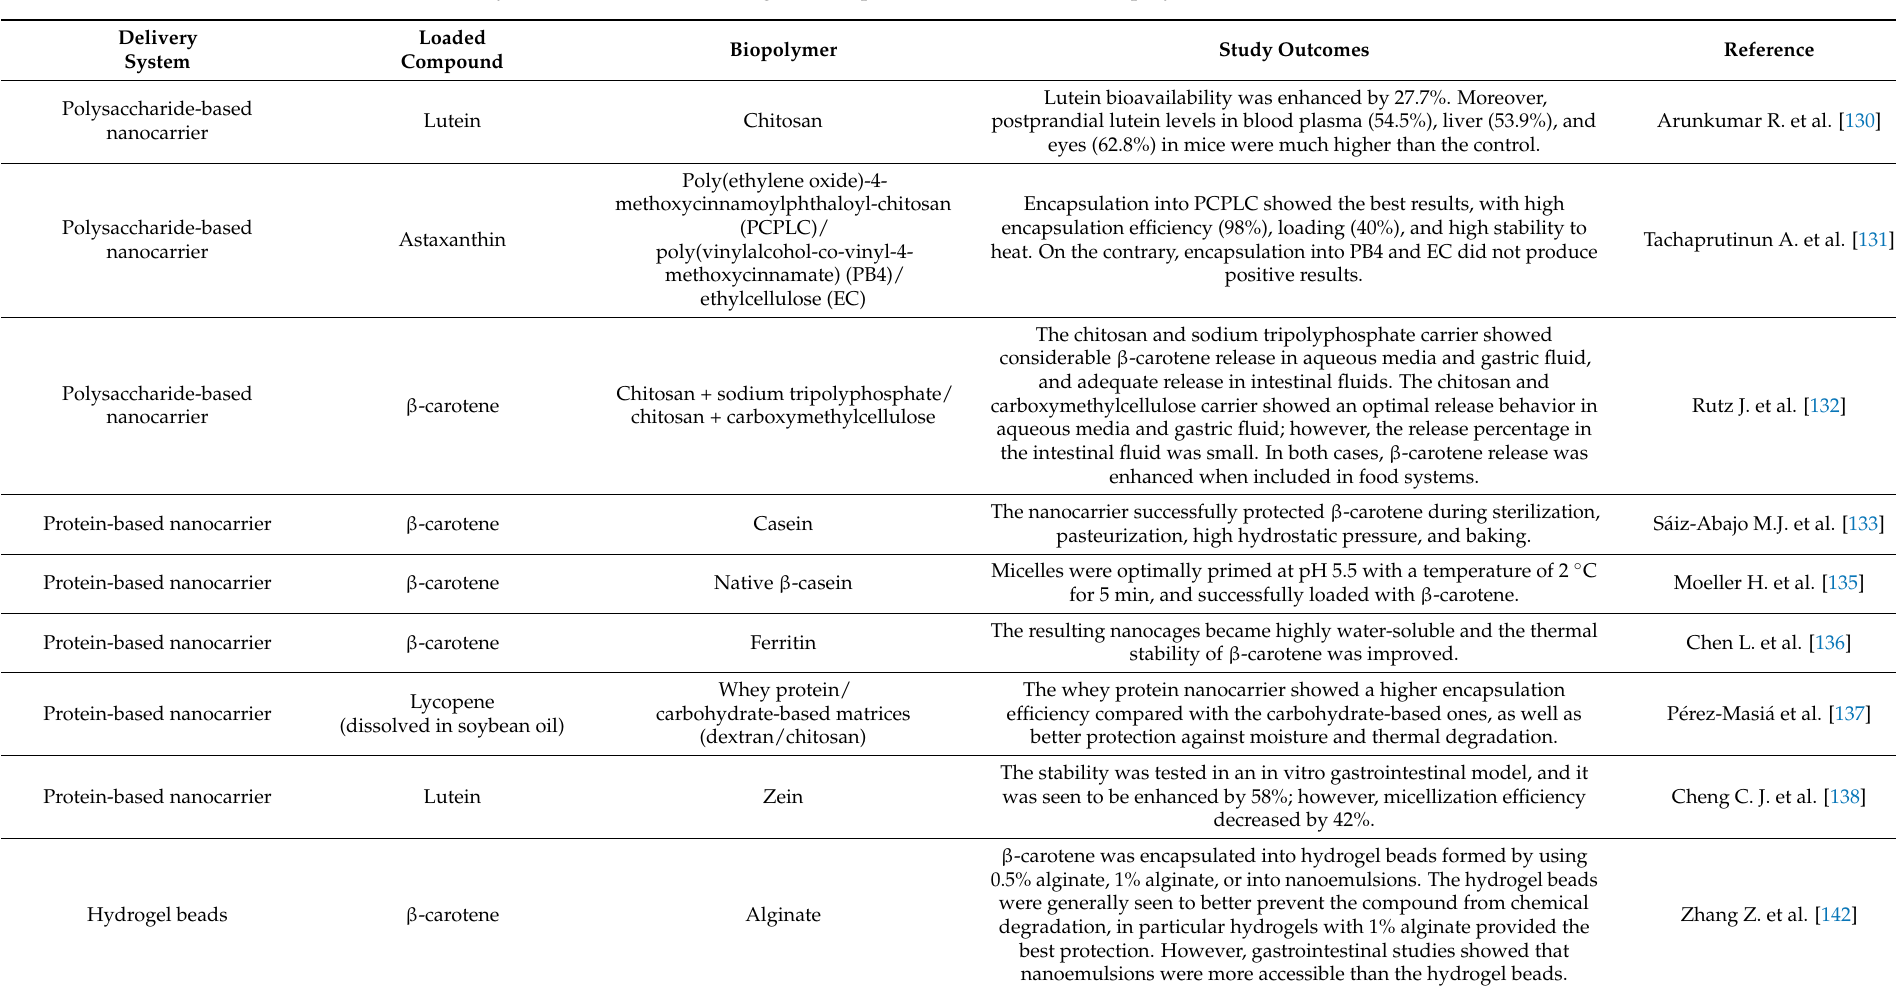
Table 2. Summary of different studies testing the encapsulation of carotenoids in polymer-based